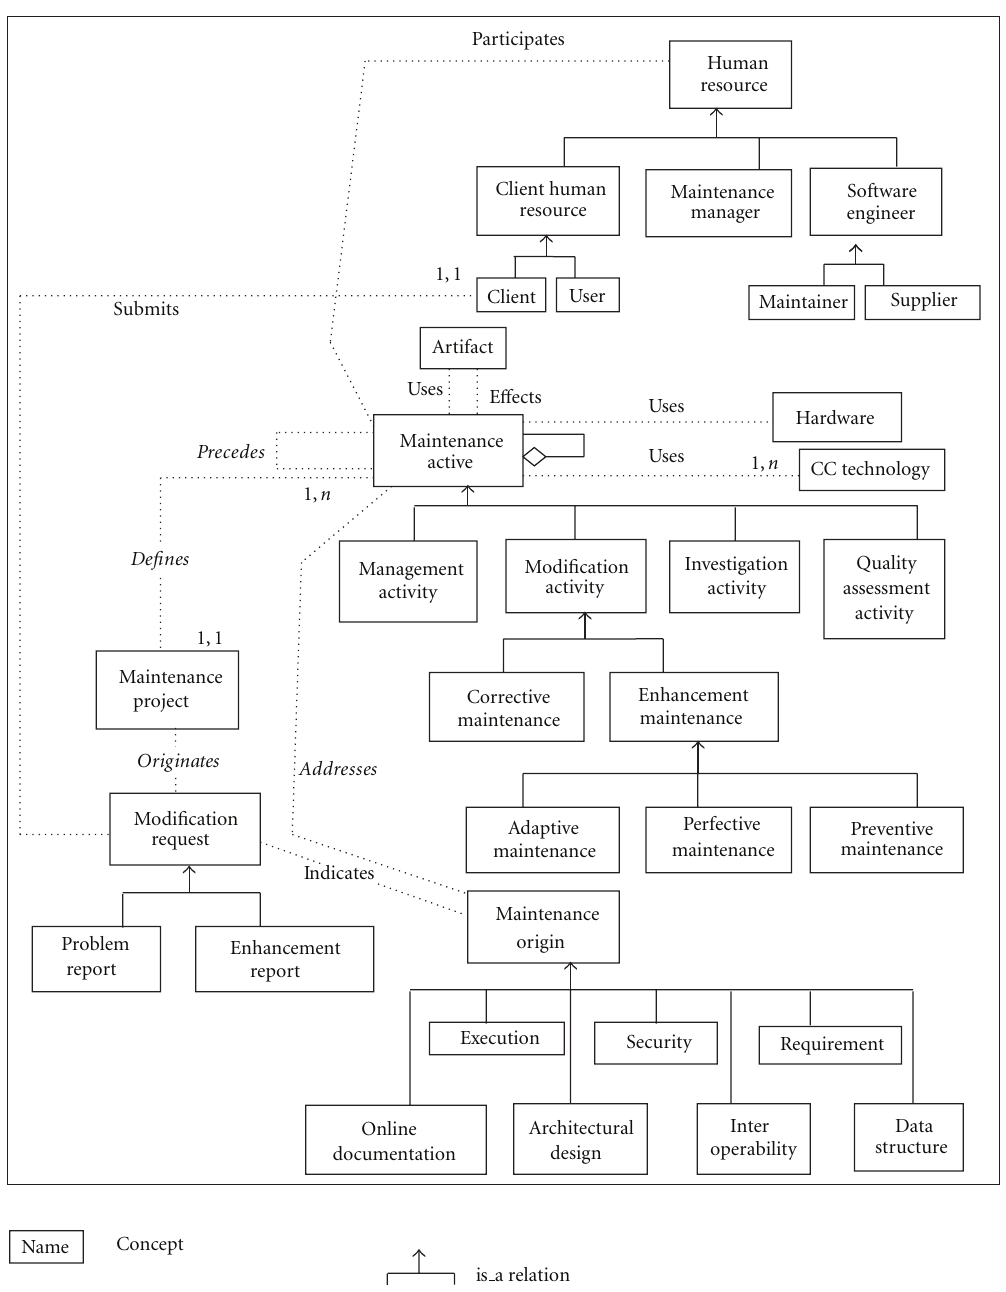
Figure 2: The modification process